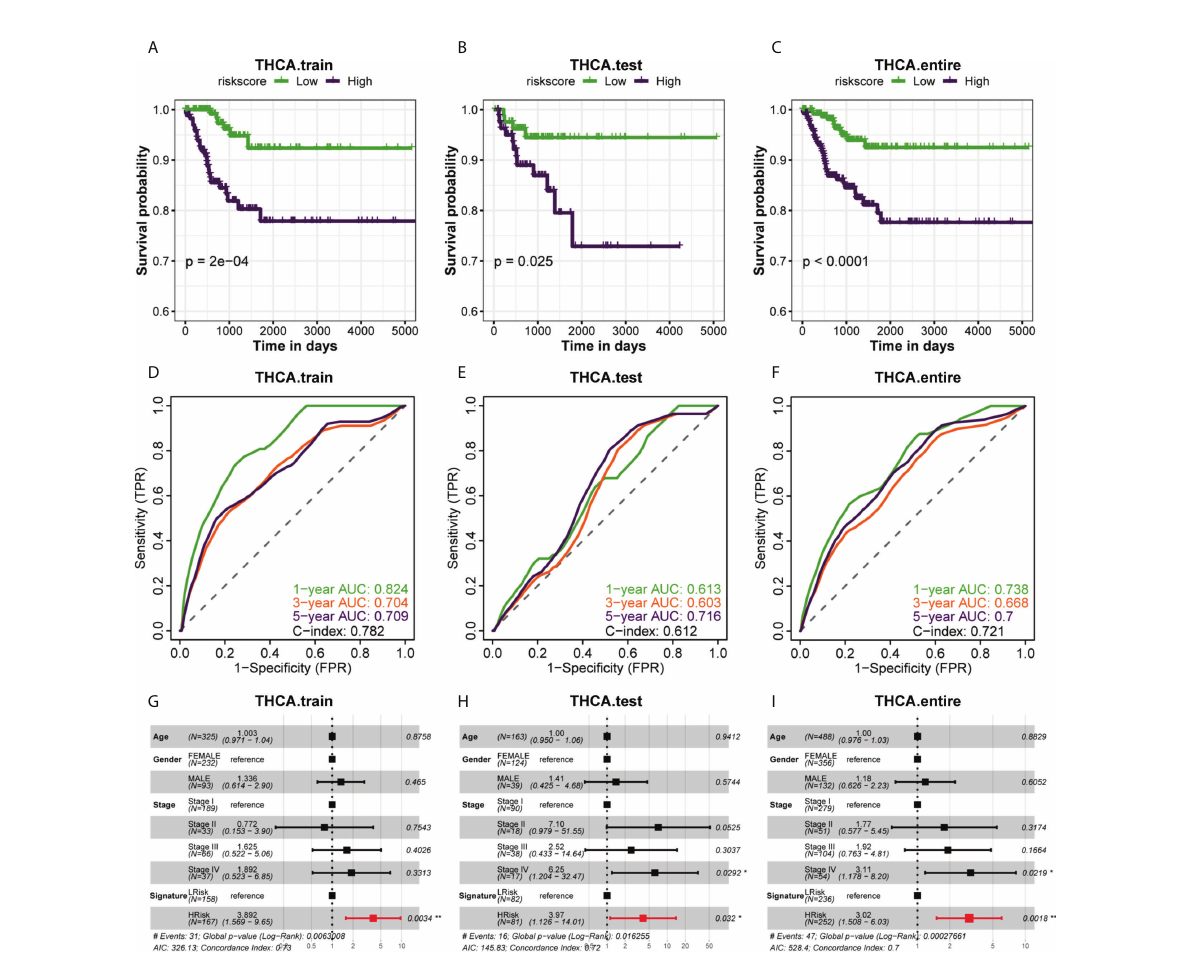
FIGURE 3 The association of different risk groups with the PFI of PTC. (A – C) The Kaplan-Meier survival curve of PFI for the three datasets (training set, test set, and entire set) in the TCGA cohort. Statistical signi fi cance of differences was developed by the log-rank test (P < 0.05 for all). (D – F) Time-dependent ROC analysis of the three datasets (training set, test set, and entire set) predicted the area under the curve of the risk score for the PFI at 1, 3, and 5 years, respectively. (G – I) Multivariate (age, gender, stage, signature) Cox regression analysis of three datasets (training set, test set, entire